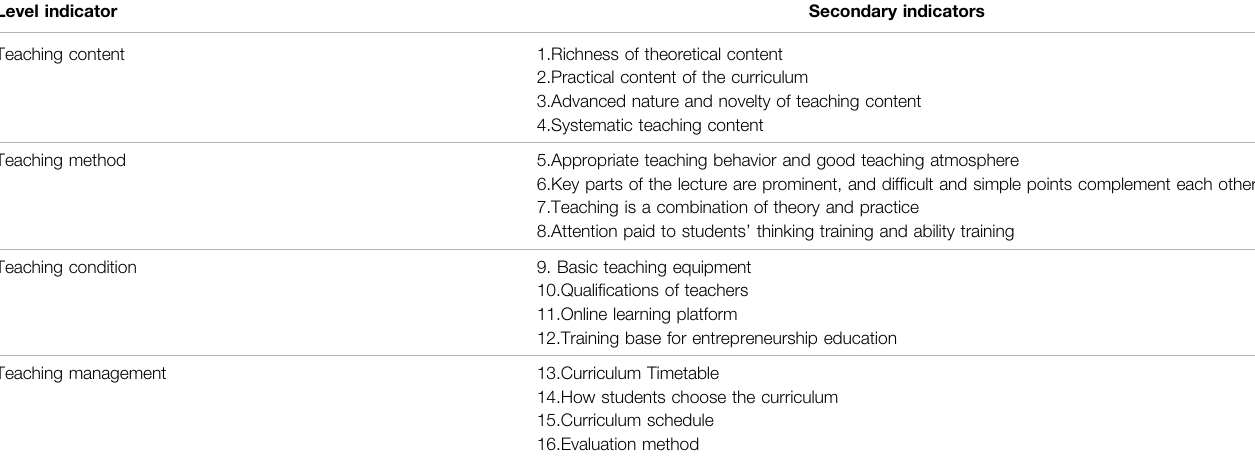
TABLE 1 | Evaluation items of students ’ perception of teaching quality based on Fundamentals of Entrepreneurship course.